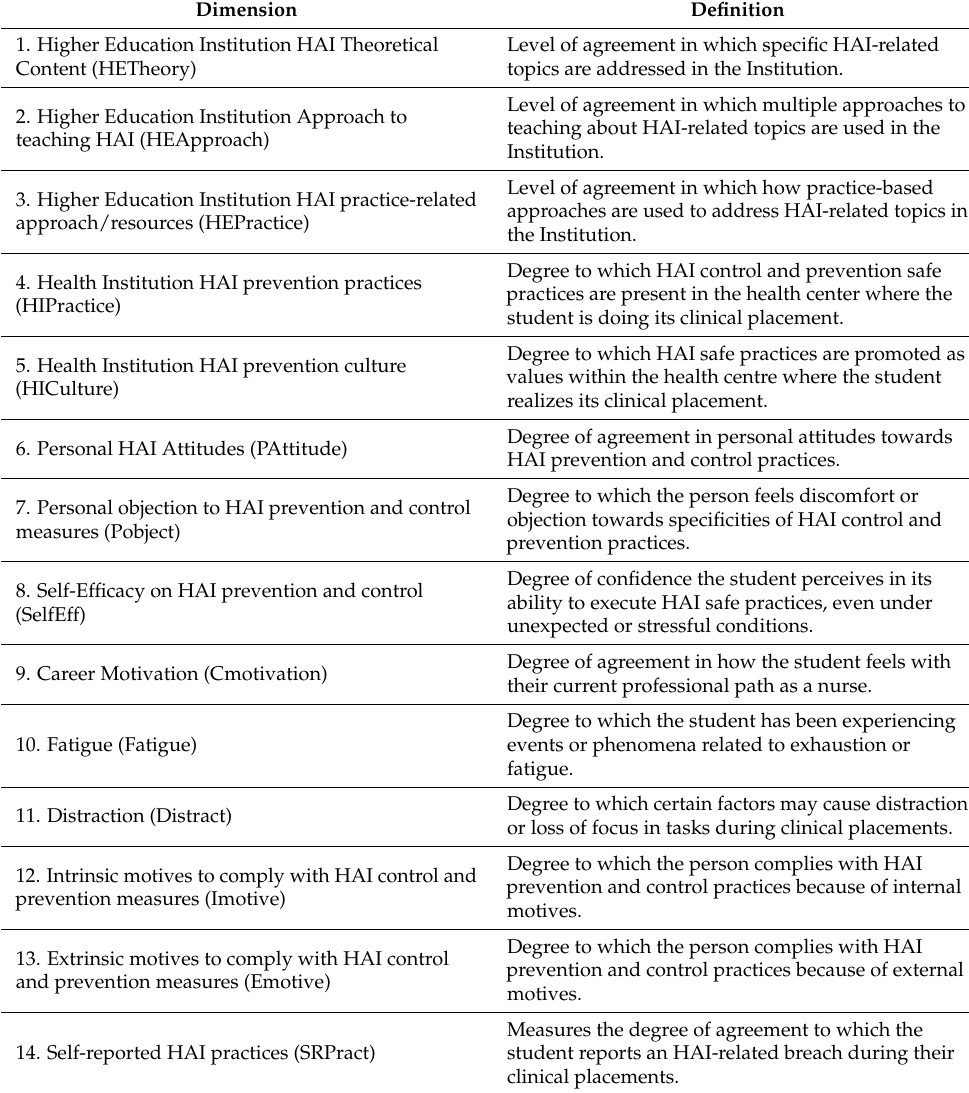
Table 1. The InovSafeCare scale’s